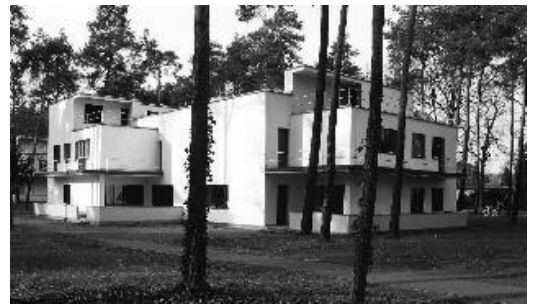
Figure 8. Walter Gropius, Masters’ houses in Dessau, 1925/26, condition in